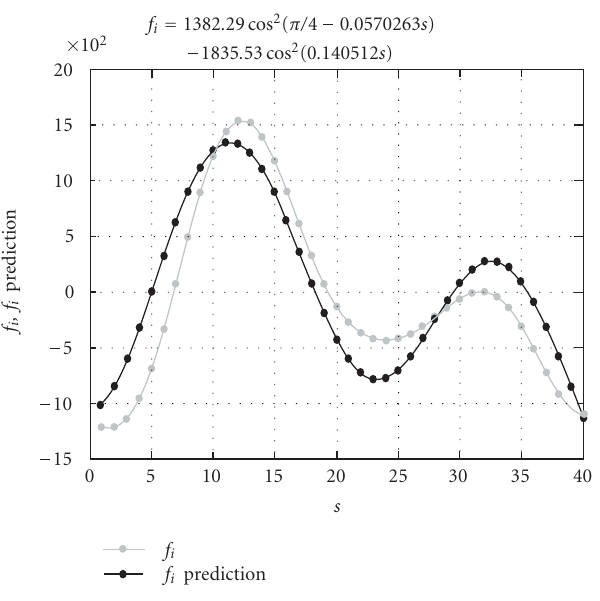
Figure 3.2. Approximation of the pressure pulse by